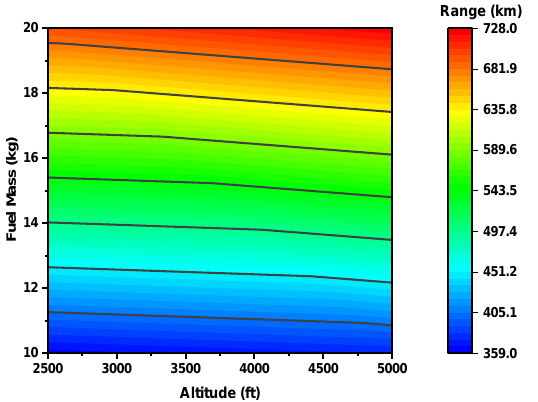
Figure 9. Hybrid electric fuel mass vs. altitude range comparison (ICE-only cruise).